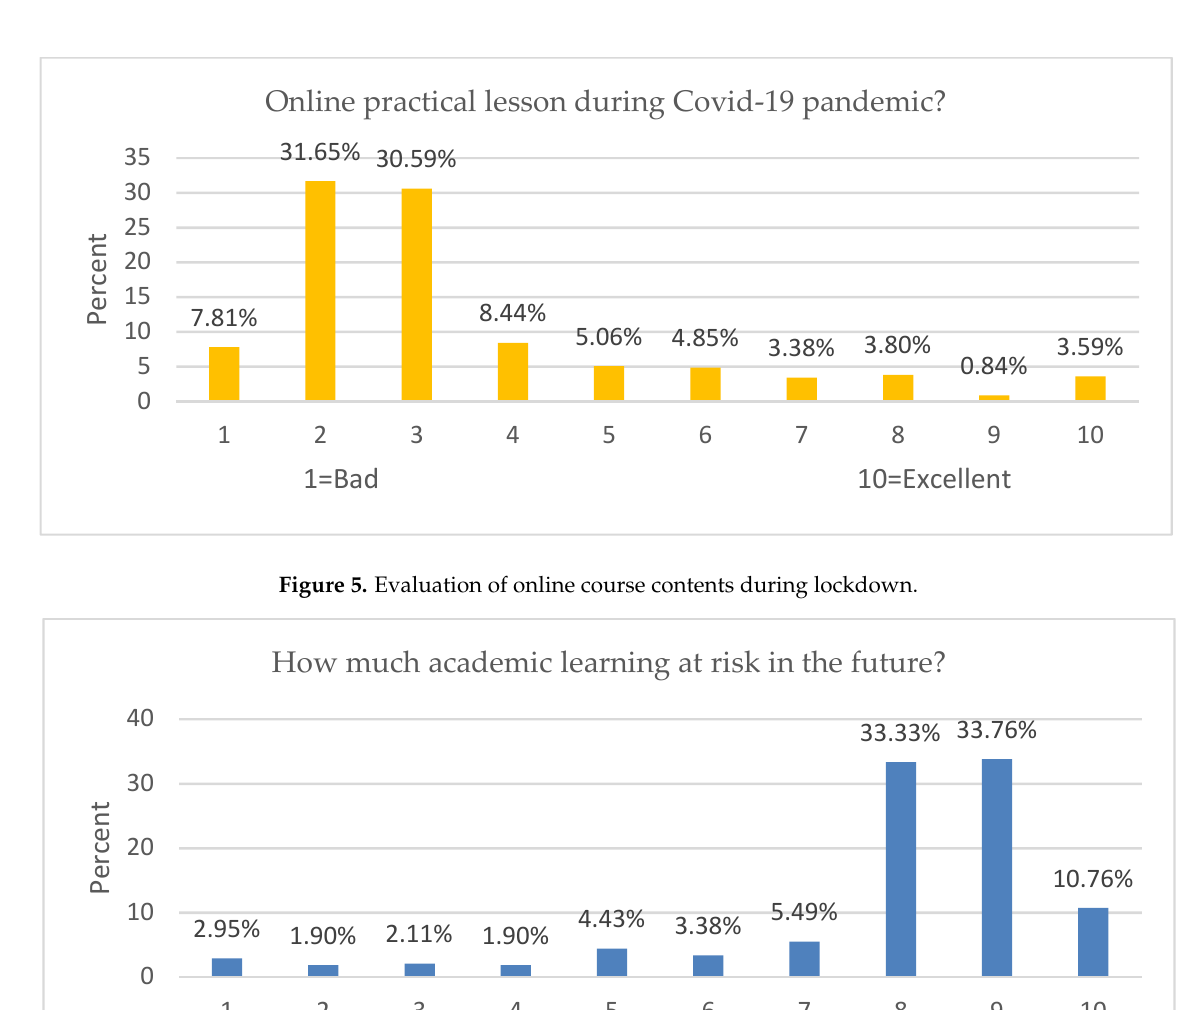
Figure 4. Evaluation of online course contents during lockdown .